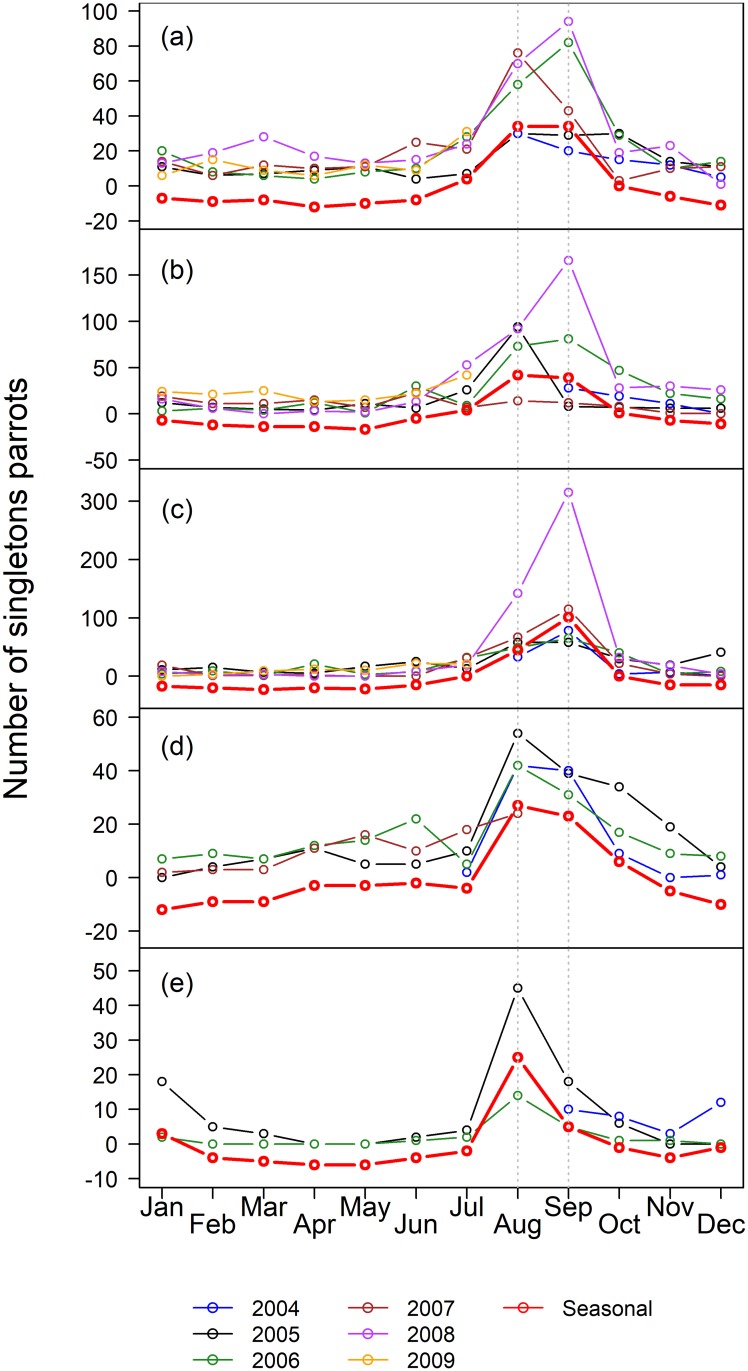
Number of singletons parrots in five roosts in the southern Pantanal of Brazil.Years are coded by colors (see the legend below the plots), and the red line indicate the seasonal component of the counts obtained by STL-decomposition analysis (see Methods). (a) Roost 1, (b) Roost 2, (c) Roost 3, (d) Roost 4, and (e) Roost 5. Vertical dotted lines indicates the months of August and September.